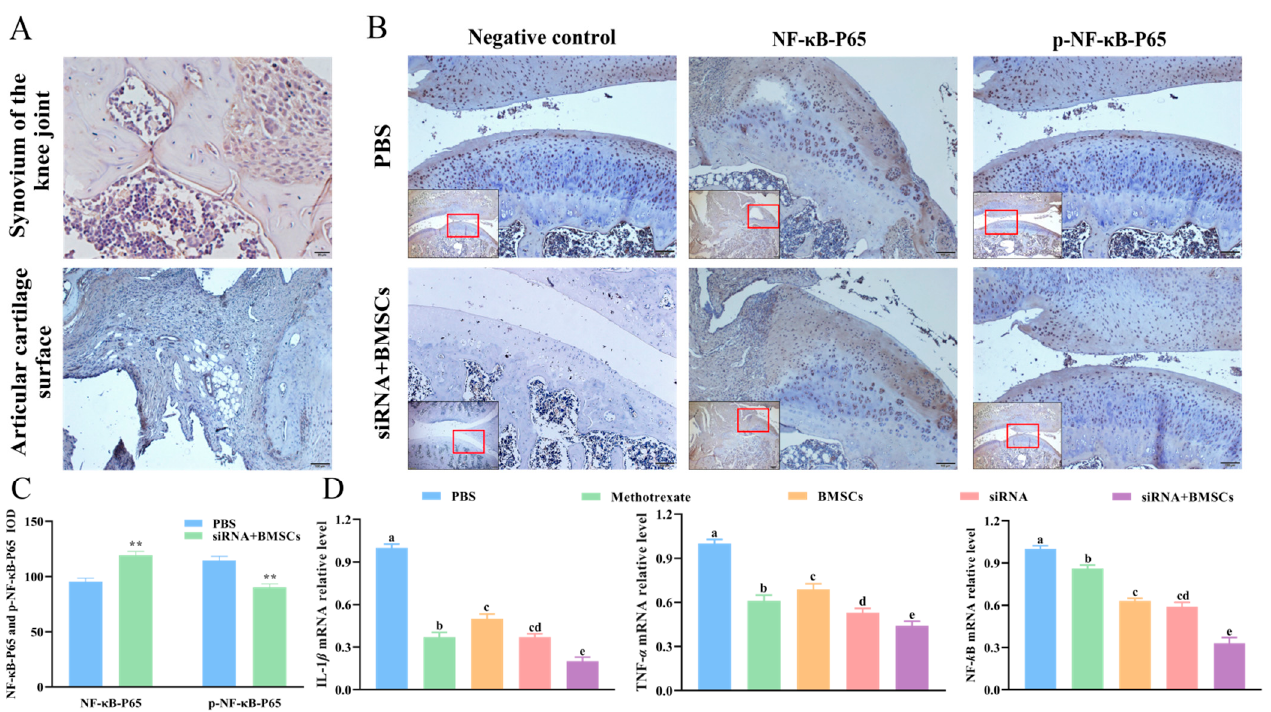
Figure 4. mRNA and protein expression in knee joint and spleen of CIA rats. ( A ), Observation of BMSCs labeled with BrdU under microscope (100 μ m, 20 μ m). ( B ), Immunohistochemical staining of NF- κ B-P65 and p-NF- κ B-P65 expression in joints of CIA rat’s knee (200 μ m, 100 μ m). ( C ), NF- κ B-P65 and p-NF- κ B-P65 expression. ( D ), IL-1 β ,TNF- α and NF- κ B-P65 mRNA expression in the spleen. Data are presented as the mean ± SD ( n = 5/group); ** p < 0.01 vs. PBS rats. Different letters mean significant difference ( p < 0.05).